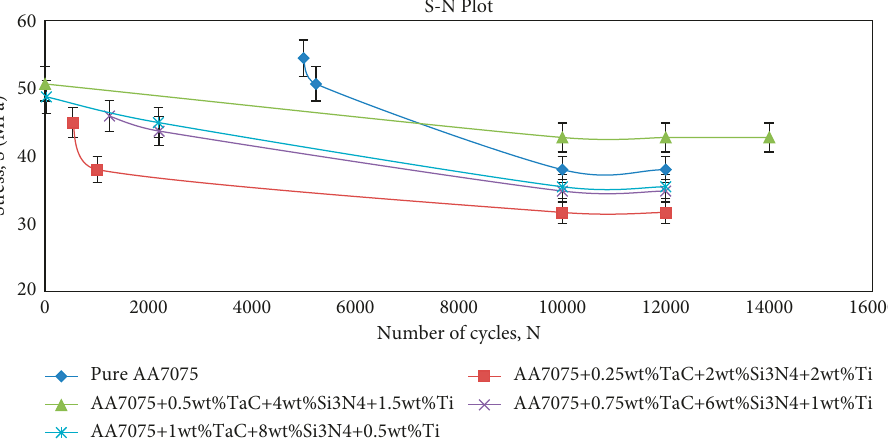
Figure 14: Deviation of cyclic stress with respect to the number of cycles.